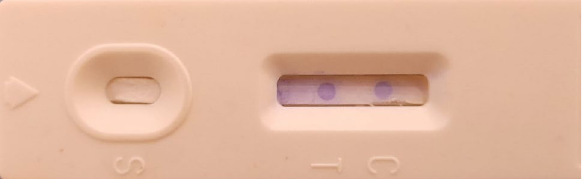
Figure 3. Demonstration of the positive reaction appearance in the newly developed kit.